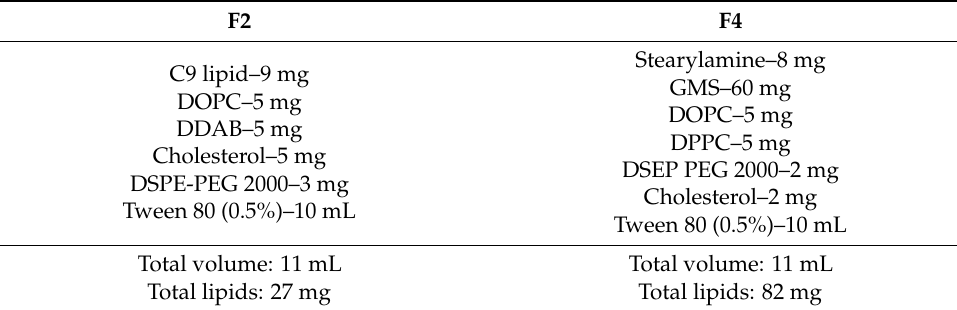
Table 2. Compositions of the F2 and F4 delivery